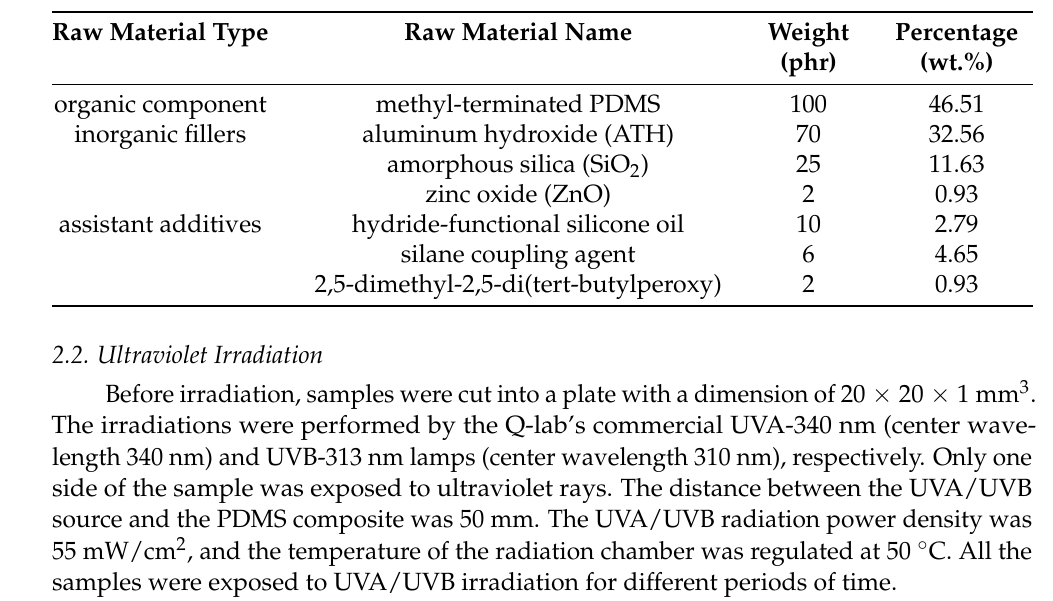
Table 1. The content of the raw materials used in the silicone